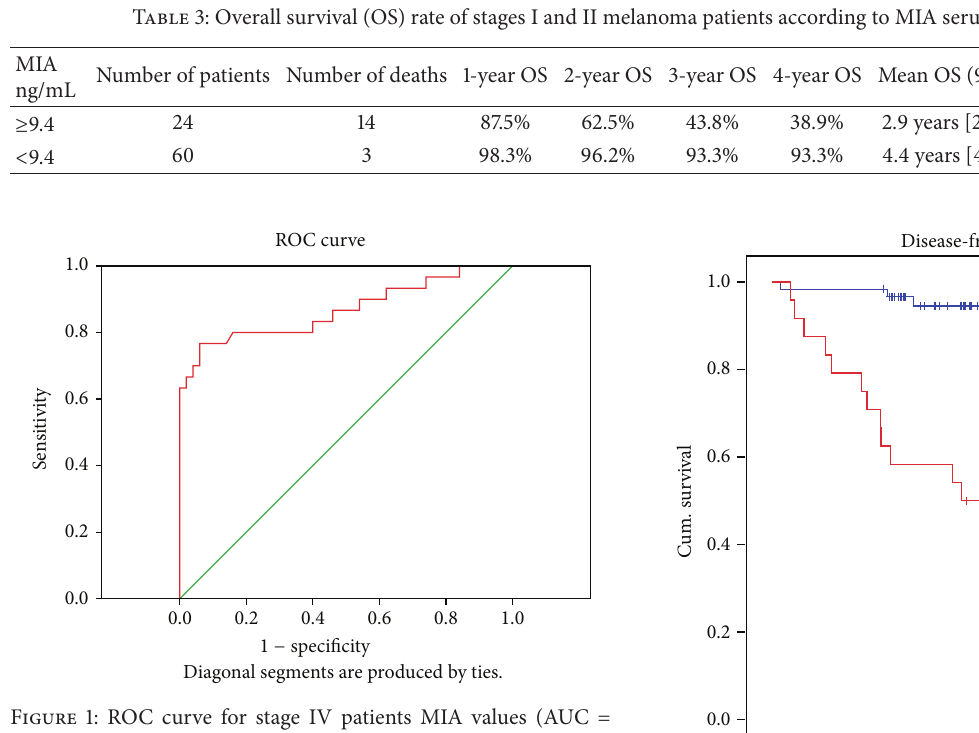
Figure 1: ROC curve for stage IV patients MIA values (AUC = 0.869).